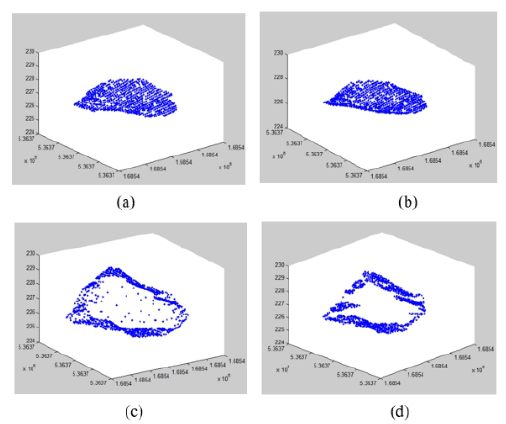
Figure 9. (a) original point cloud (b) algorithm in this paper(IMLS) (c) inverse distance wieght(IDW) interpolation (d) nearest neighbor